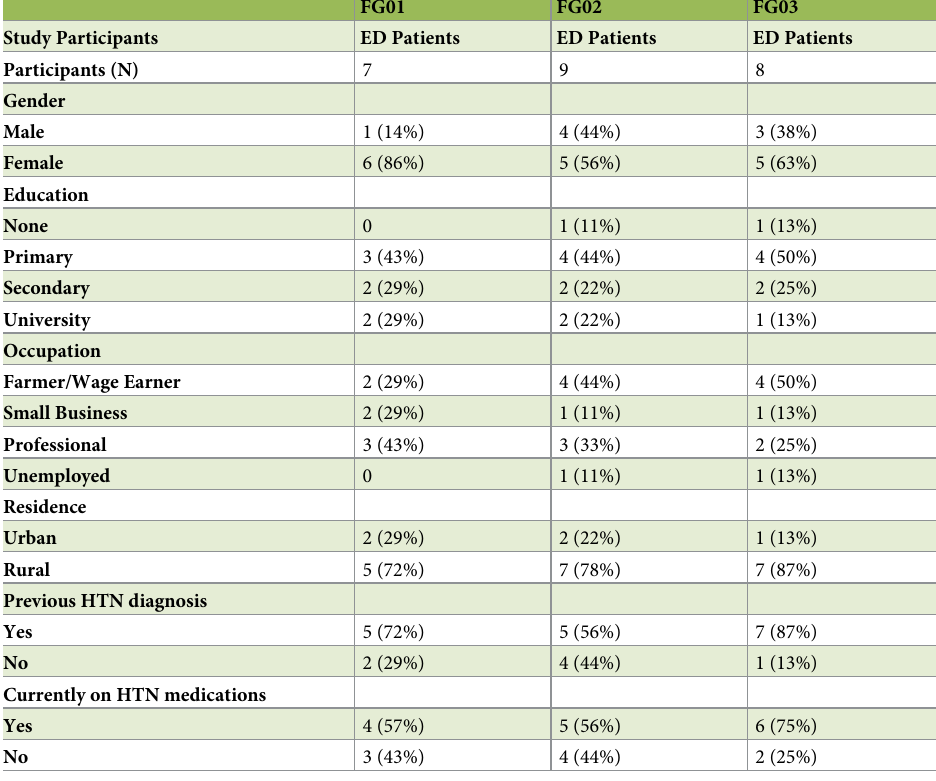
Table 1. Characteristics of the focus group